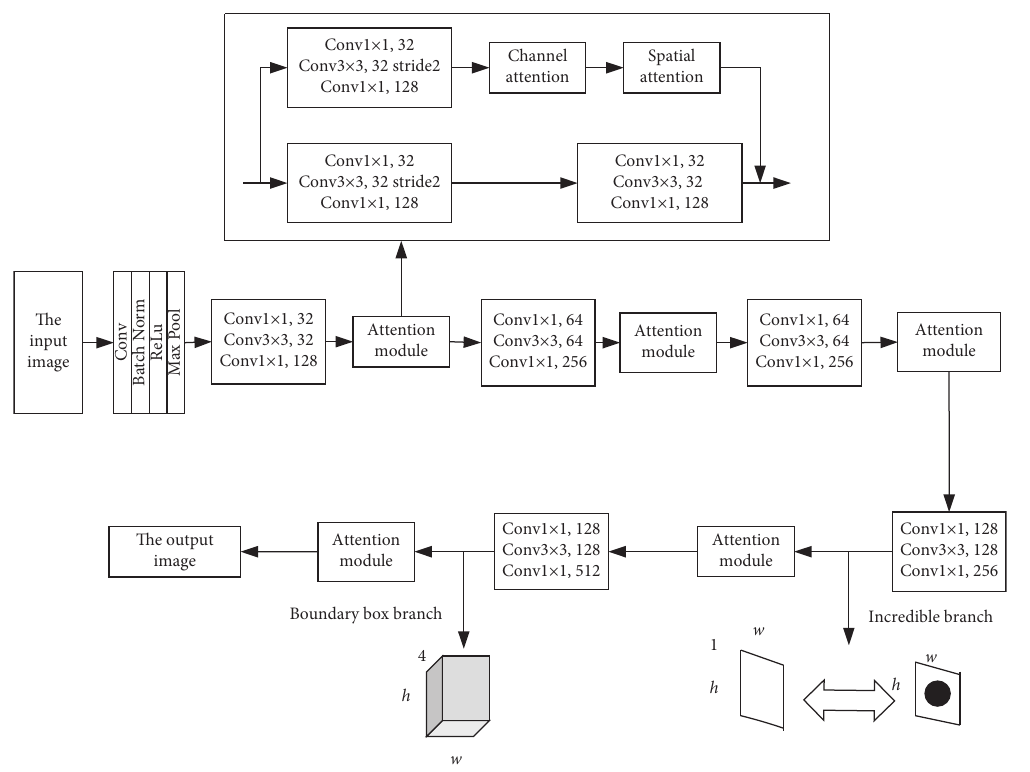
Figure 6: Network structure of deep residual network. Table 1: The experimental results compared with different fusion